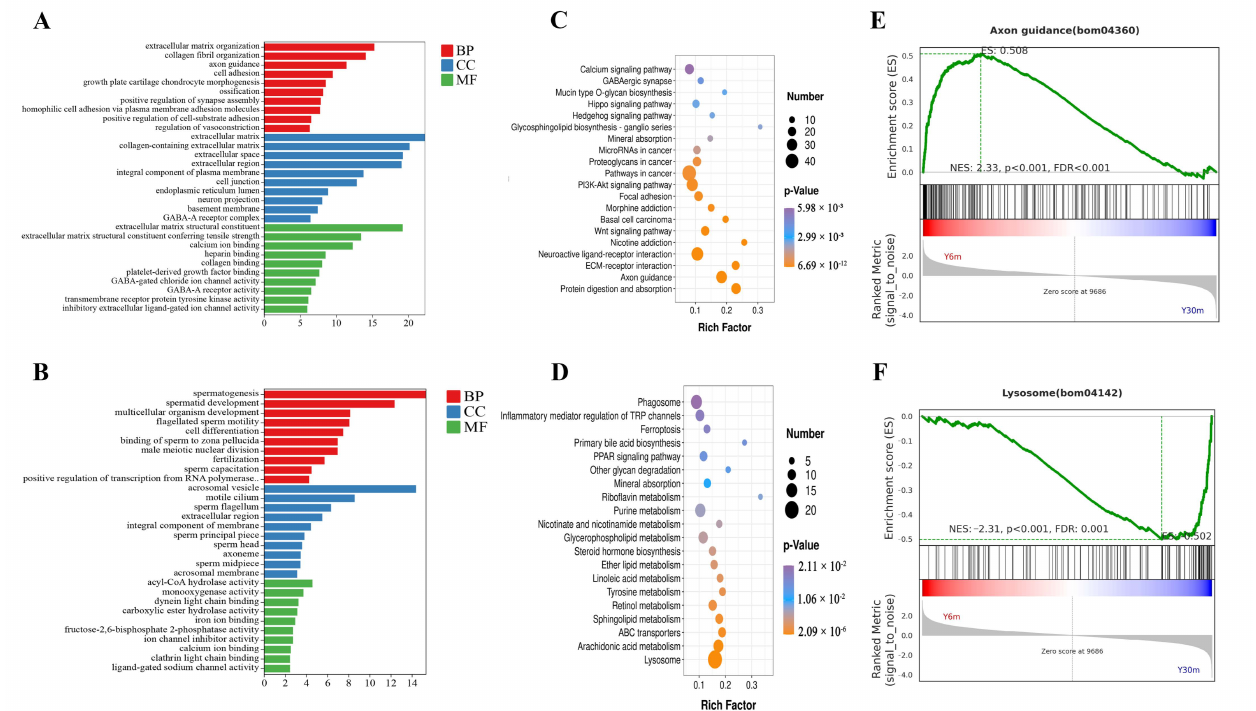
Figure 3. GO, KEGG, and GSEA analyses for DEGs. GO enrichment analysis of DEGs showed that